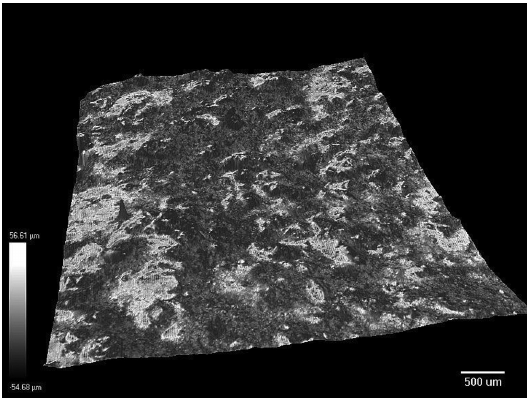
Figure 5. Texture of surface of the ceramic foam showing the distribution of segregated phases of oxides of aluminum and titanium (black) over mullite substrate